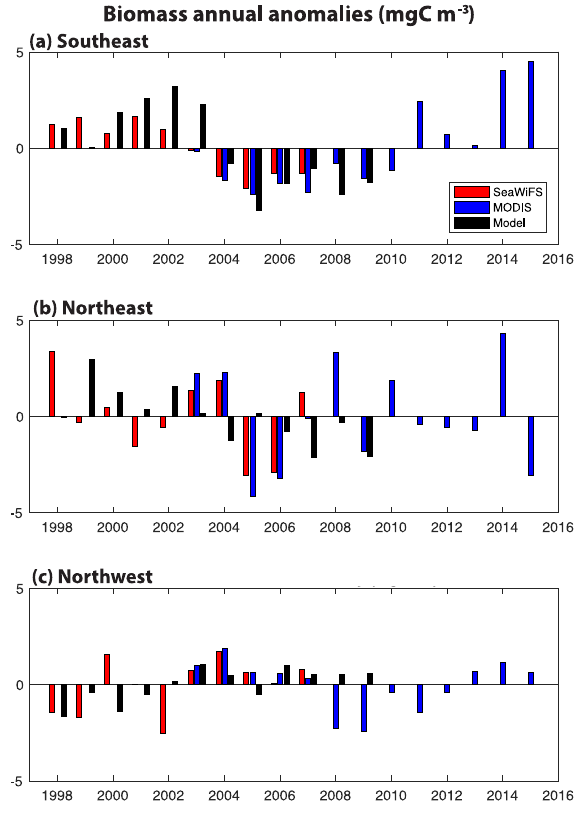
Figure 2. Annual anomalies of surface ocean biomass for SeaW- iFS (1998–2007, red), MODIS (2003–2015, blue) and our model (1998–2009, 0–100m, black): (a) SE region, (b) NE region and (c) NW region. The corresponding monthly time series is shown in Fig.